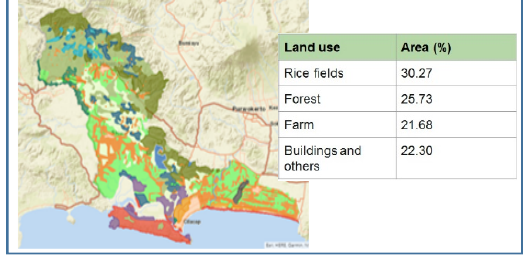
Figure 6. Land use in Cilacap, Central Java (Kanzulfawaid. 2011)